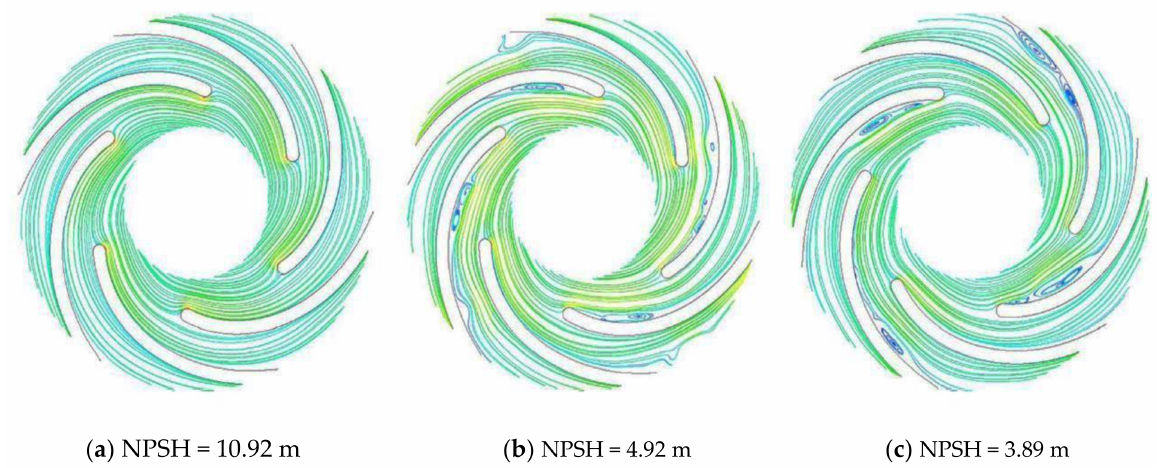
Figure 13. Streamline behavior for impeller under different NPSH ( a – c )